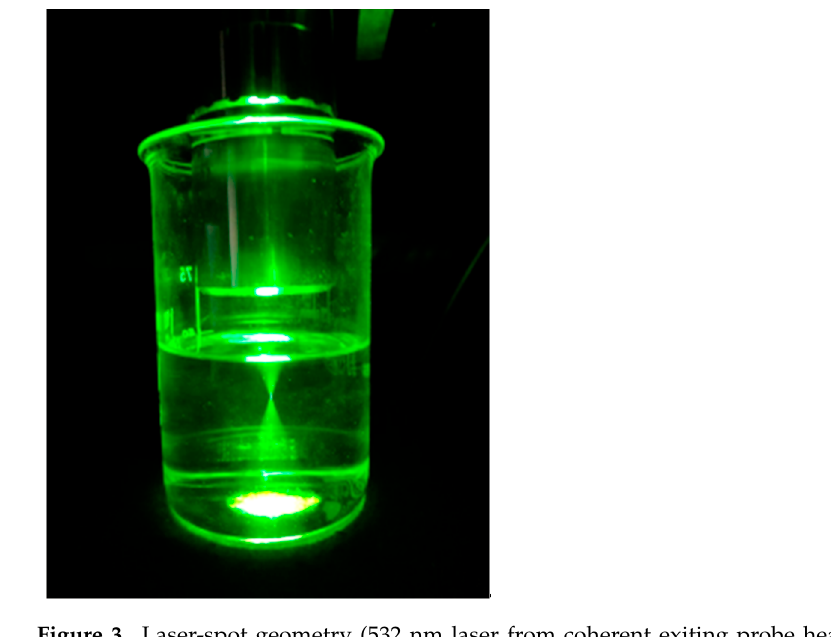
Figure 3. Laser-spot geometry (532 nm laser from coherent exiting probe head (#7 in Figure 2) in water).